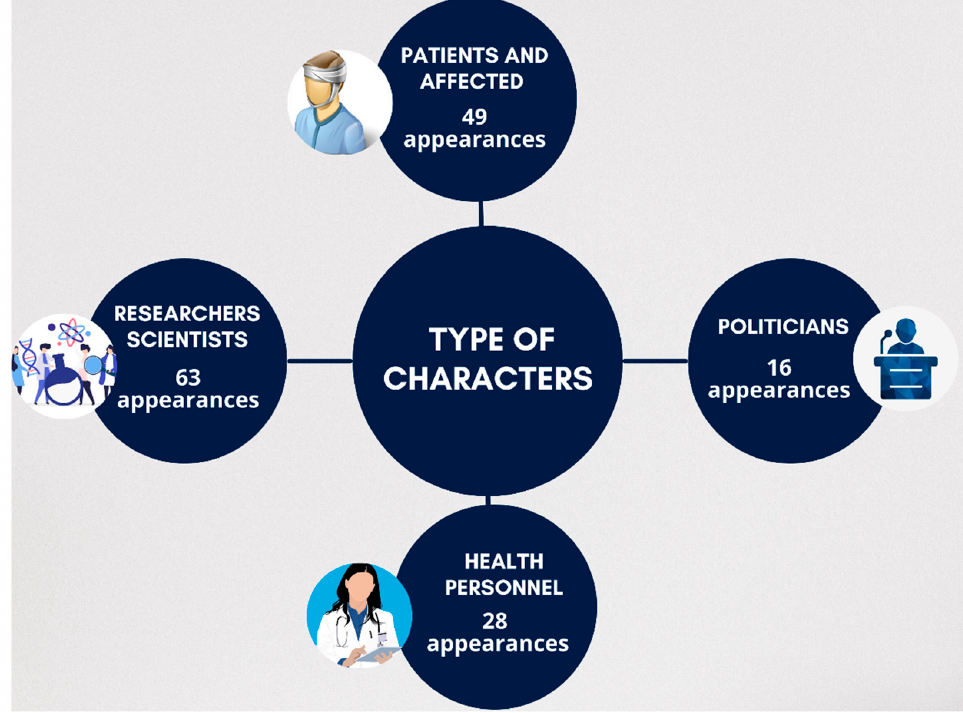
Figure 4. Type of characters that appeared in the cover stories.